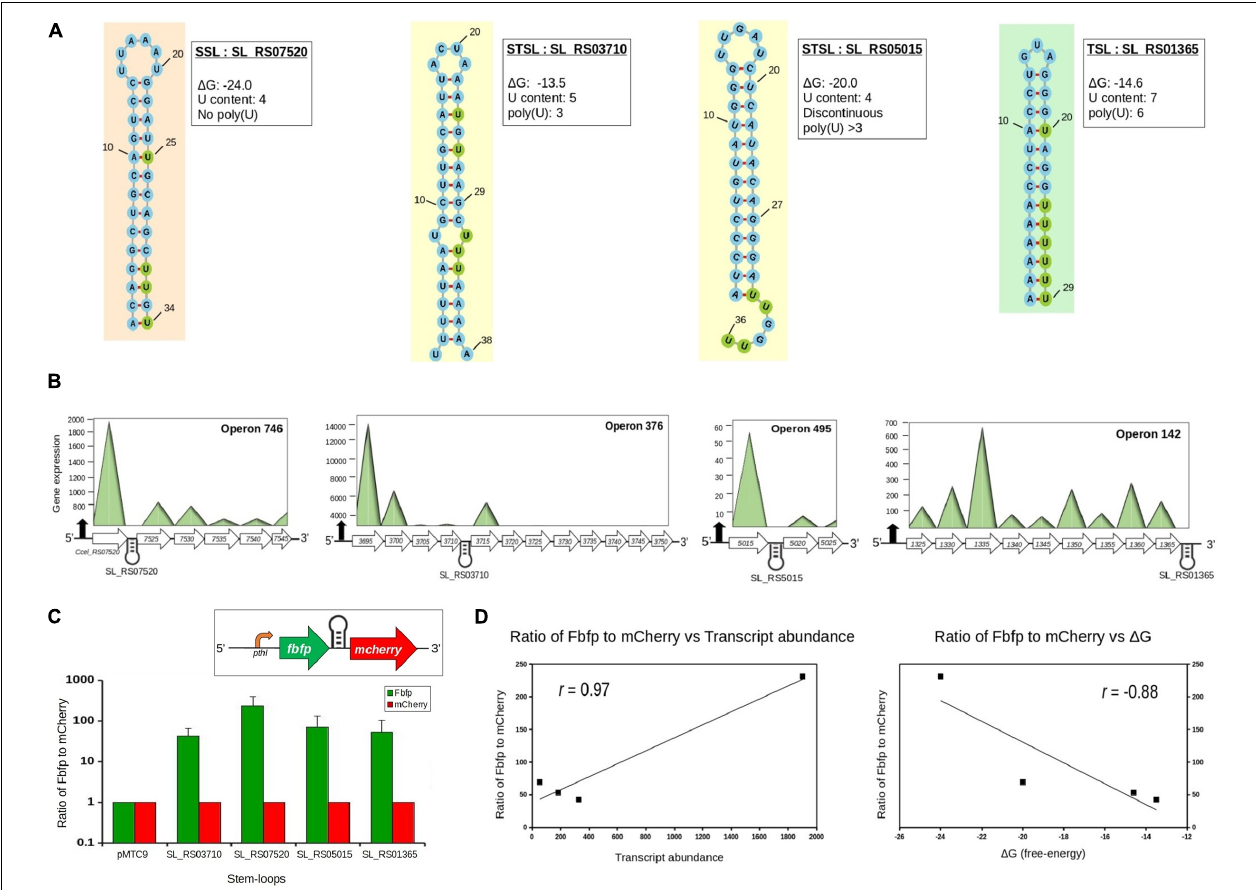
FIGURE 2 | Functional classification and experimental validation of the stem–loops (SLs) in Clostridium cellulolyticum . (A) Structures of the four in silico predicted SLs used in the functional analysis, which were inserted into the artificial operon ( in vitro ). The uridines (U) are highlighted in green , showing the poly(U) tail and the U content of the SLs. Based on the poly(U) tail/U content information, the SLs were classified into stabilizer (SSL), stabilizer and terminator (STSL), and terminator (TSL) categories. (B) In vivo , i.e., four different operons with the location of the SLs used in functional analysis. The mountain plots represent the actual gene expression of each gene in operons. (C) In vitro , i.e., the relative transcription level of fbfp and mCherry as measured by qPCR. The relative abundances for SL_RS07520 (SSL), SL_RS03710 (STSL), SL_RS05015 (STSL), and SL_RS01365 (TSL) are 231.25, 42.52, 69.39, and 53.45, respectively. Error bars : standard deviations of three replicate experiments. The inset represents the dual-fluorescent artificial operon for the functional analysis of the SL structures. (D) Correlations between the relative transcript levels of fbfp to mCherry and the transcript abundance of the gene upstream to the SL ( p = 0.08, one-tailed Student’s t -test) and between the relative transcript levels of fbfp to mCherry and (cid:49) G of the inserted SLs in each of the four